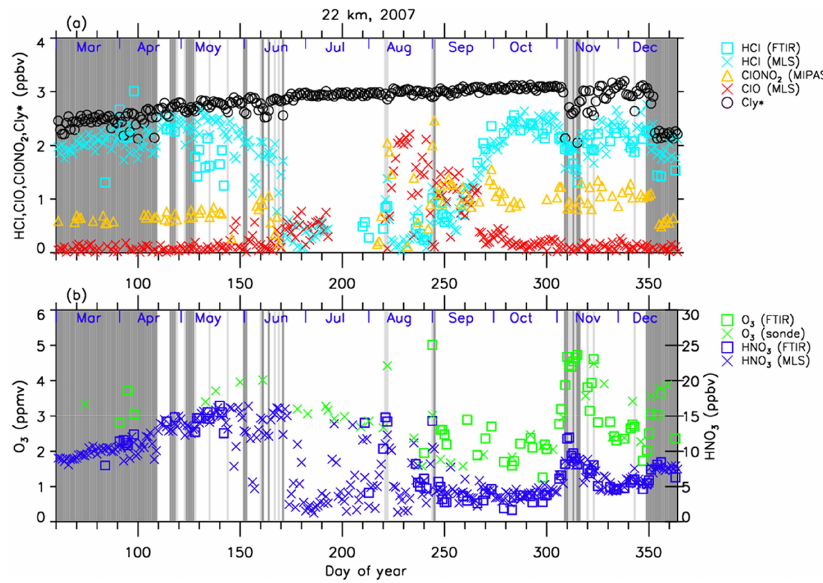
Figure 6. Same as Fig. 4 but at 22km.